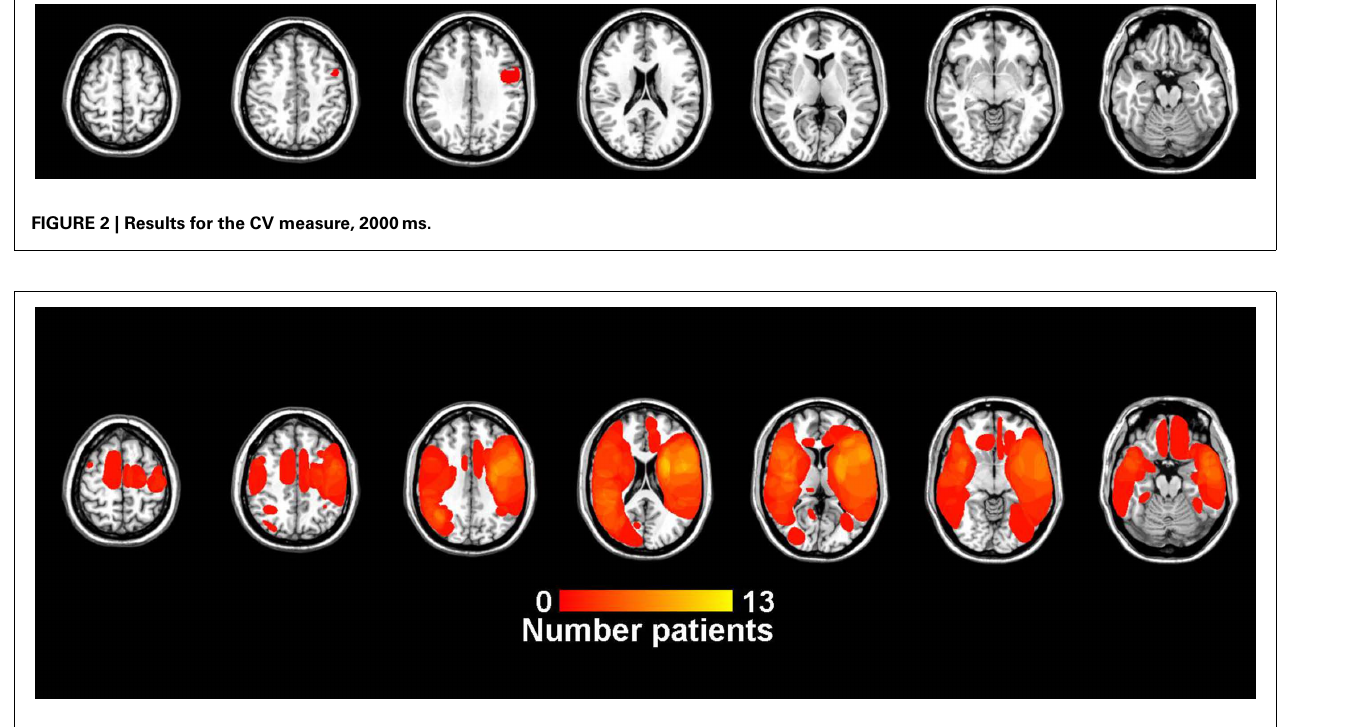
The scale runs from dark red to bright yellow, with brighter yellow indicating a greater number of patients with a lesion at that voxel. Lower right is a legend with number of lesions at each